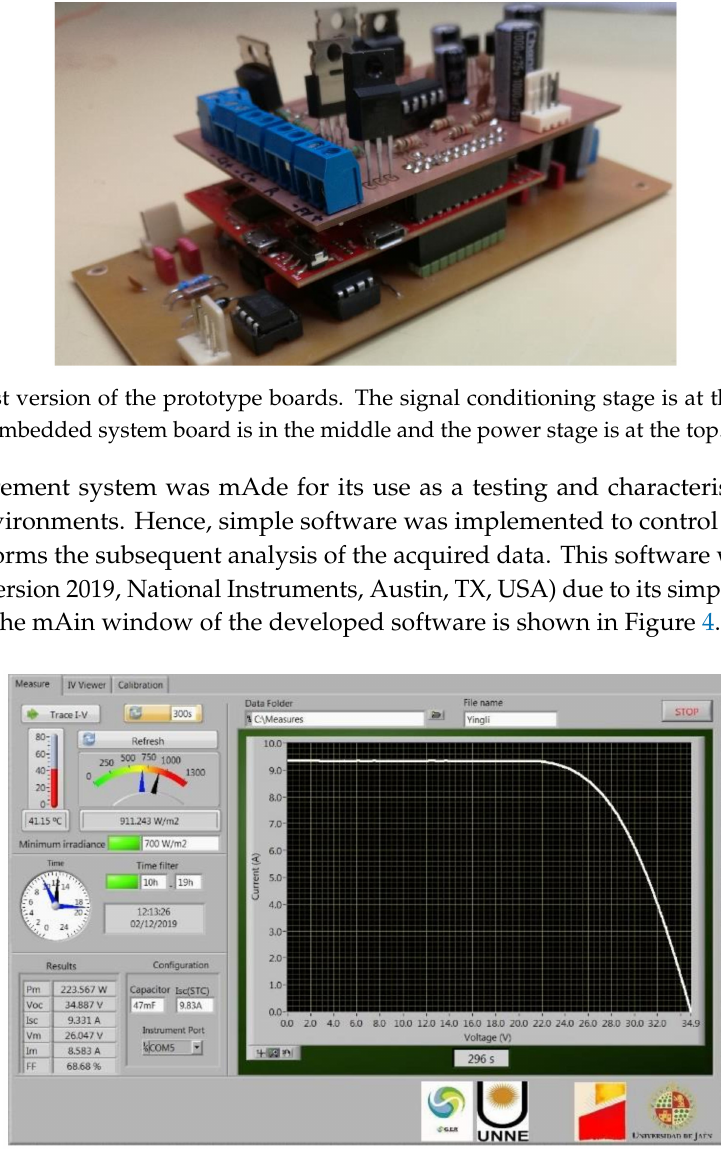
Figure 4. Main window of the developed control